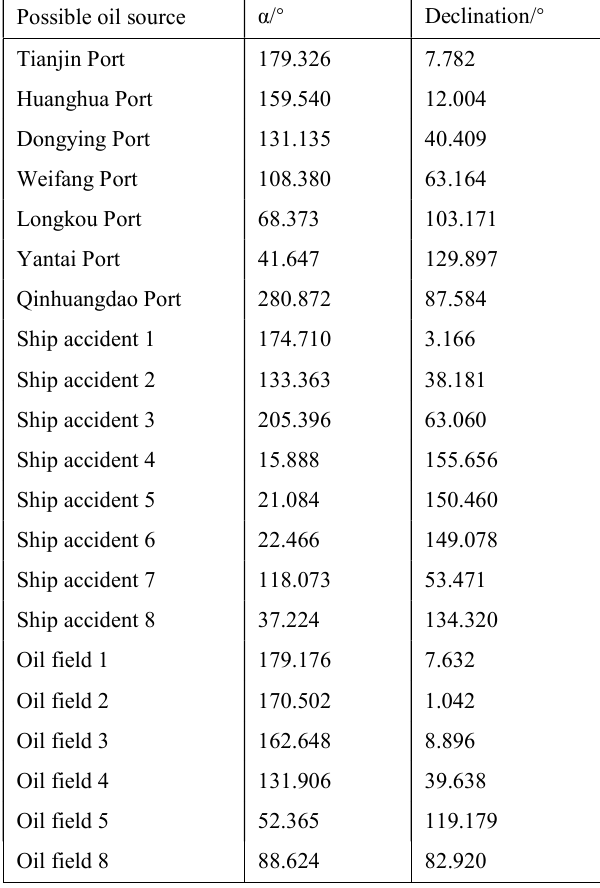
Table 1. Deviation angles from the main